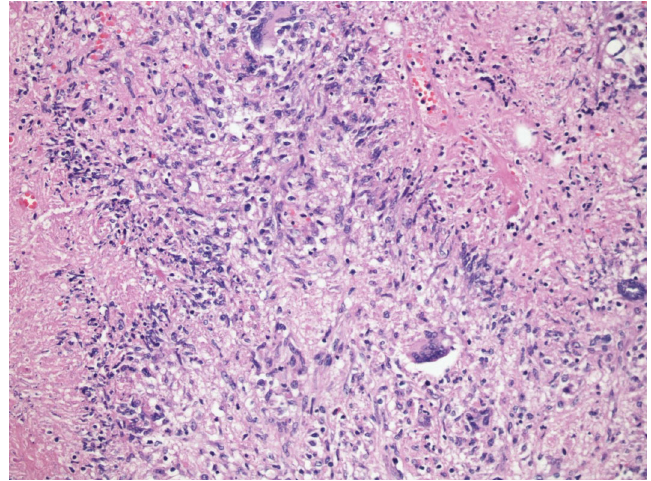
Figure 9: H&E biopsy specimen from a right partial hepatectomy shows necrotizing granulomas with giant cells and characteristic palisading histiocytes in an immunocompetent patient diagnosed with granulomatous hepatitis due to Bartonella henselae infection. (Image obtained with permission from VanderHeyden et al.